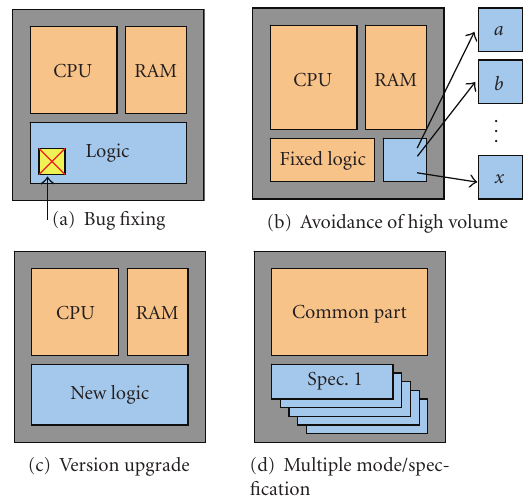
Figure 1: The use of a VGLC as a reconfigurable logic core.